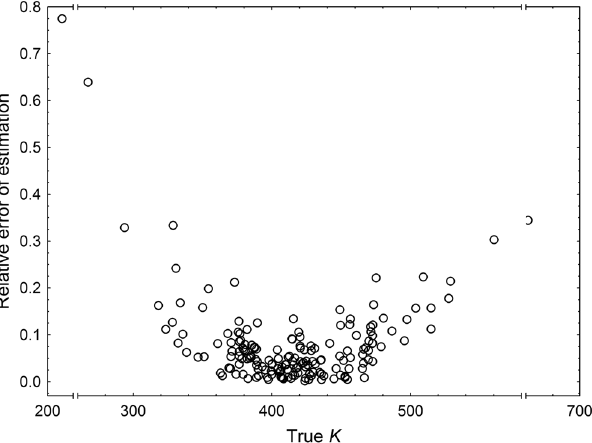
Figure 5. Relative error in estimates of physiological age ( K ) at emergence of C. maxillosus plotted against the true age. K was estimated using sex-specific models regressing K and beetle length at